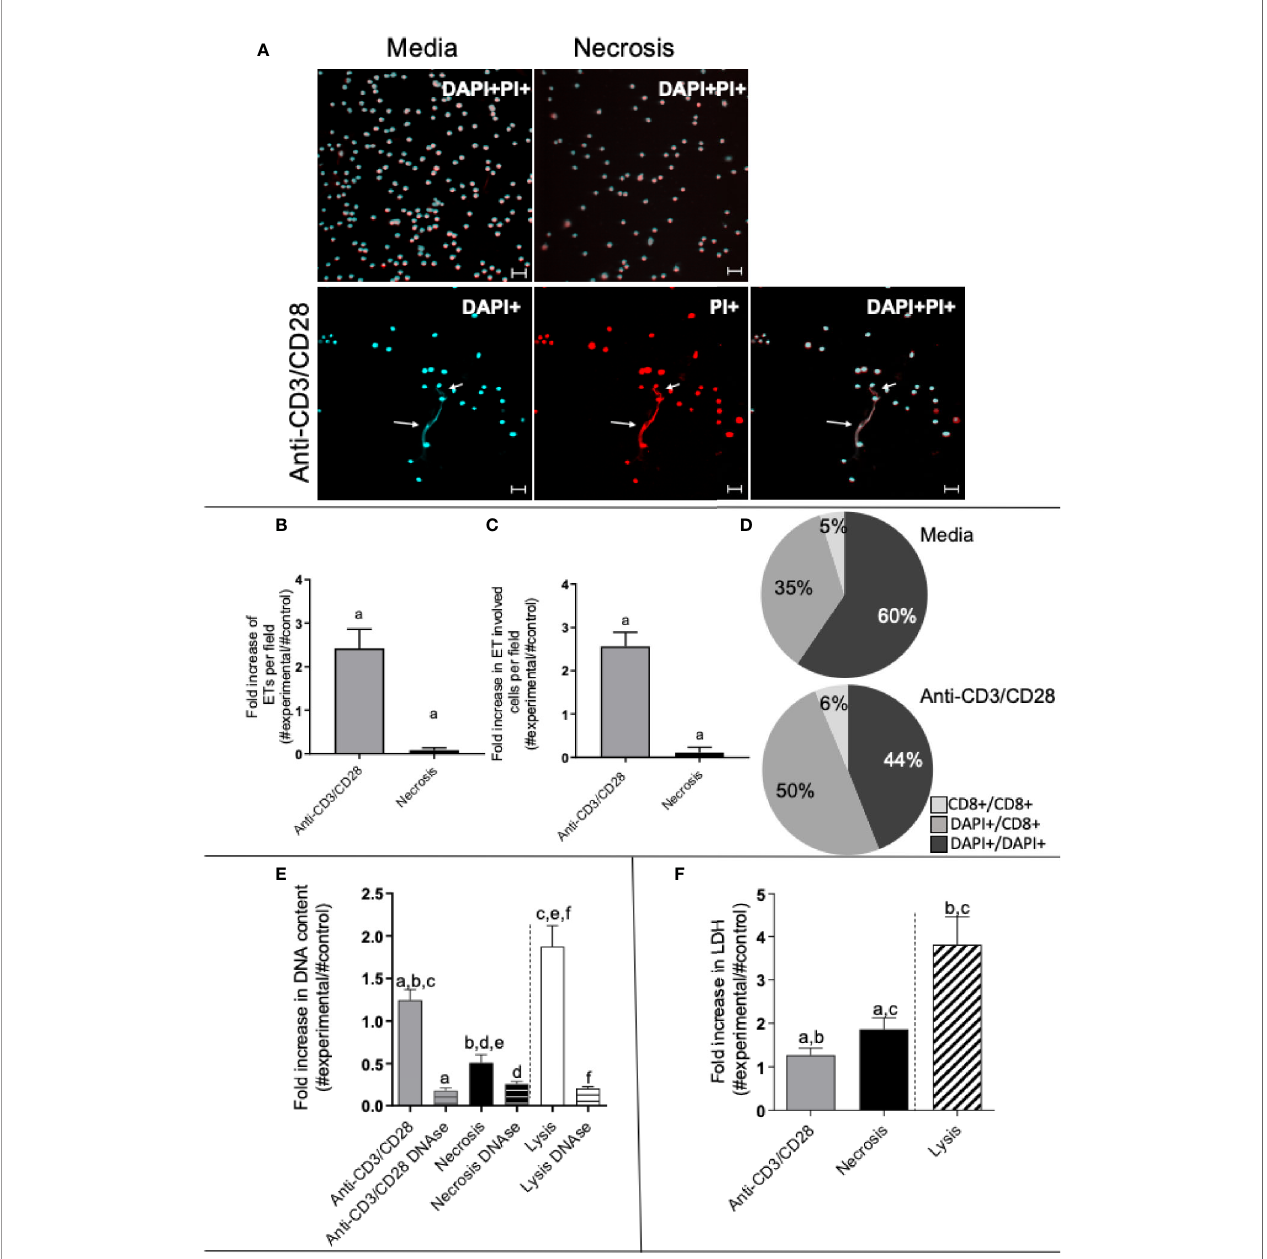
FIGURE 1 | Anti-CD3/anti-CD28 stimulation leads to the release of extracellular traps by T-lymphocyte enriched cultures. (A) Representative confocal image of non- stimulated culture (media), necrosis-induced culture (necrosis) and culture stimulated with anti-CD3/anti-CD28 stained with DAPI (light blue) and propidium iodide (PI - red). Arrows highlight extracellular DNA (extracellular traps – ETs) observed in the stimulated cultures. Bars = 20 m m. (B) Quanti fi cation of ETs after stimulation or induction of necrosis. (C) Quanti fi cation of the number of cells participating in the ETs in each group. (D) Determination of the frequency of ETs connecting DAPI+ cells to DAPI+ cells (DAPI+/DAPI+), any DAPI+ cells to CD8+ cells (DAPI+/CD8+) and CD8+ cells to CD8+ cells (CD8+/CD8+), as indicated, in non-stimulated and anti-CD3/anti-CD28 stimulated cultures. (E) Double-stranded DNA was quanti fi ed in the culture supernatant using the PicoGreen dsDNA kit (Invitrogen), according to the manufacturer ’ s instructions. (F) Evaluation of necrosis by quanti fi cation of LDH release. The release of LDH into the culture supernatant was assessed by spectrophotometry (340 nm) using a commercial kit (Bioclin), according to the manufacturer ’ s instructions. Data is presented as average per group ± standard error of the mean. Same letters in different bars represents statistically signi fi cant differences between